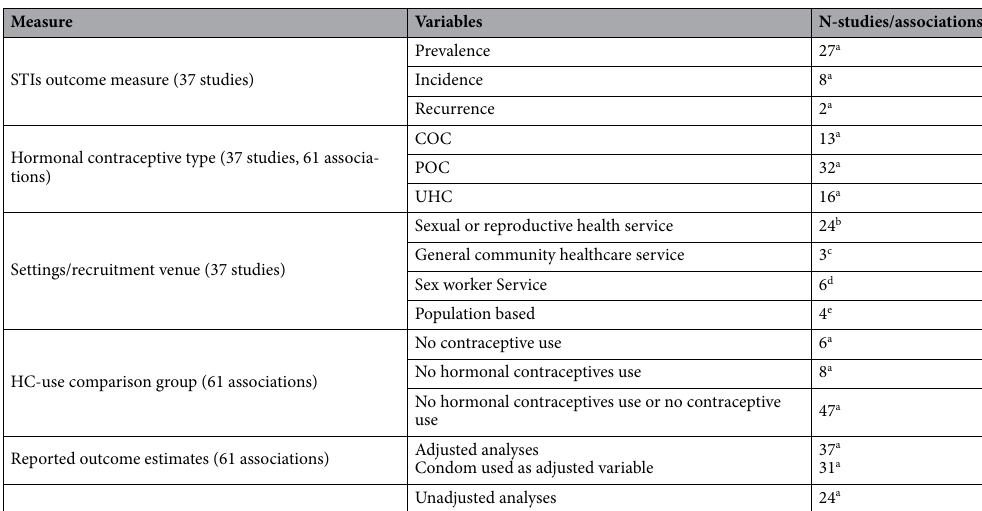
Table 2. Assessment of bias: measures of the studies included in the analysis. a References provided in Table 1. b Ashraf Ganjoei 38 , Bradshaw et al. 39,57 , Brotman et al. 50 , Bukusi et al. 51 , Cherpes et al. 44 , Evans et al. 43 ,